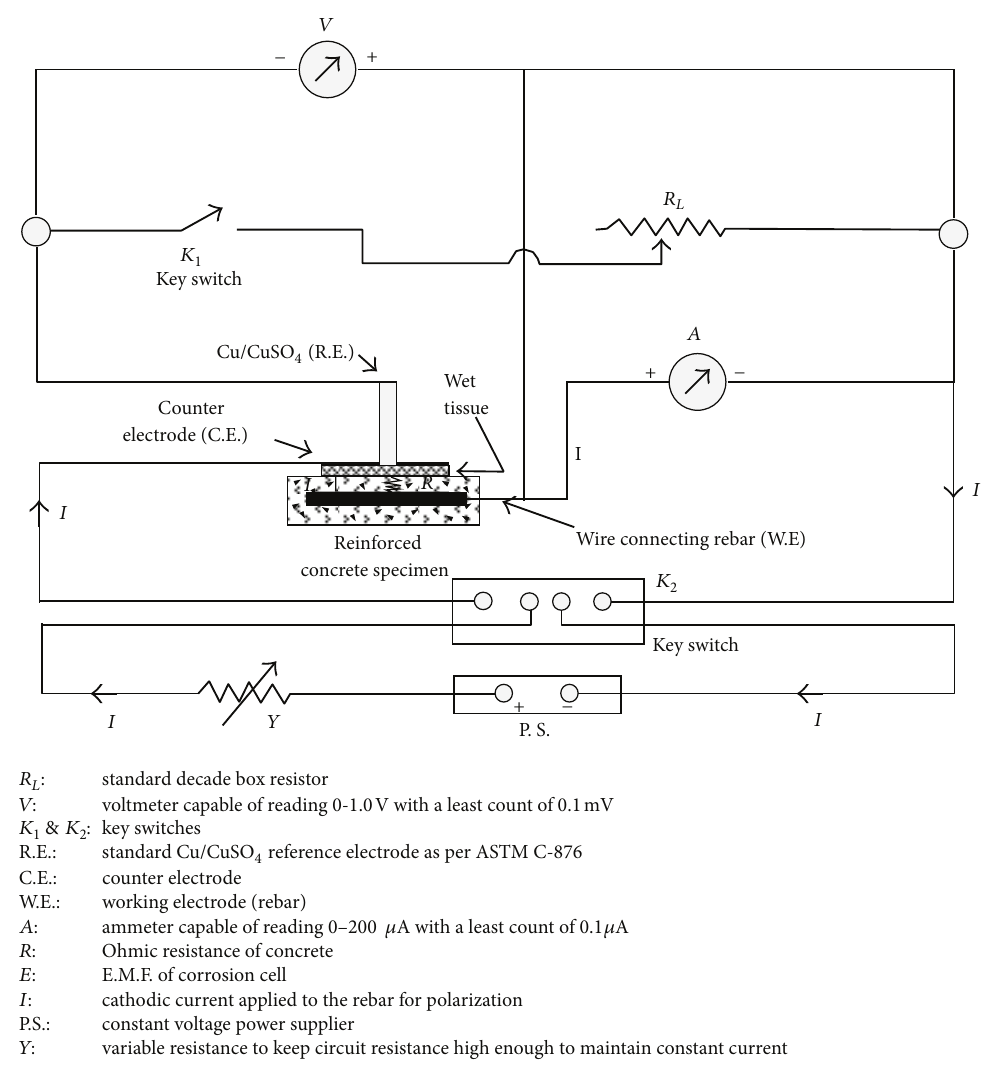
Figure 1: Experimental setup for generating the data pertaining to corrosion potential, Ohmic resistance, and polarization resistance (modified version of the setup proposed earlier by Ahmad and Bhattacharjee [8]).